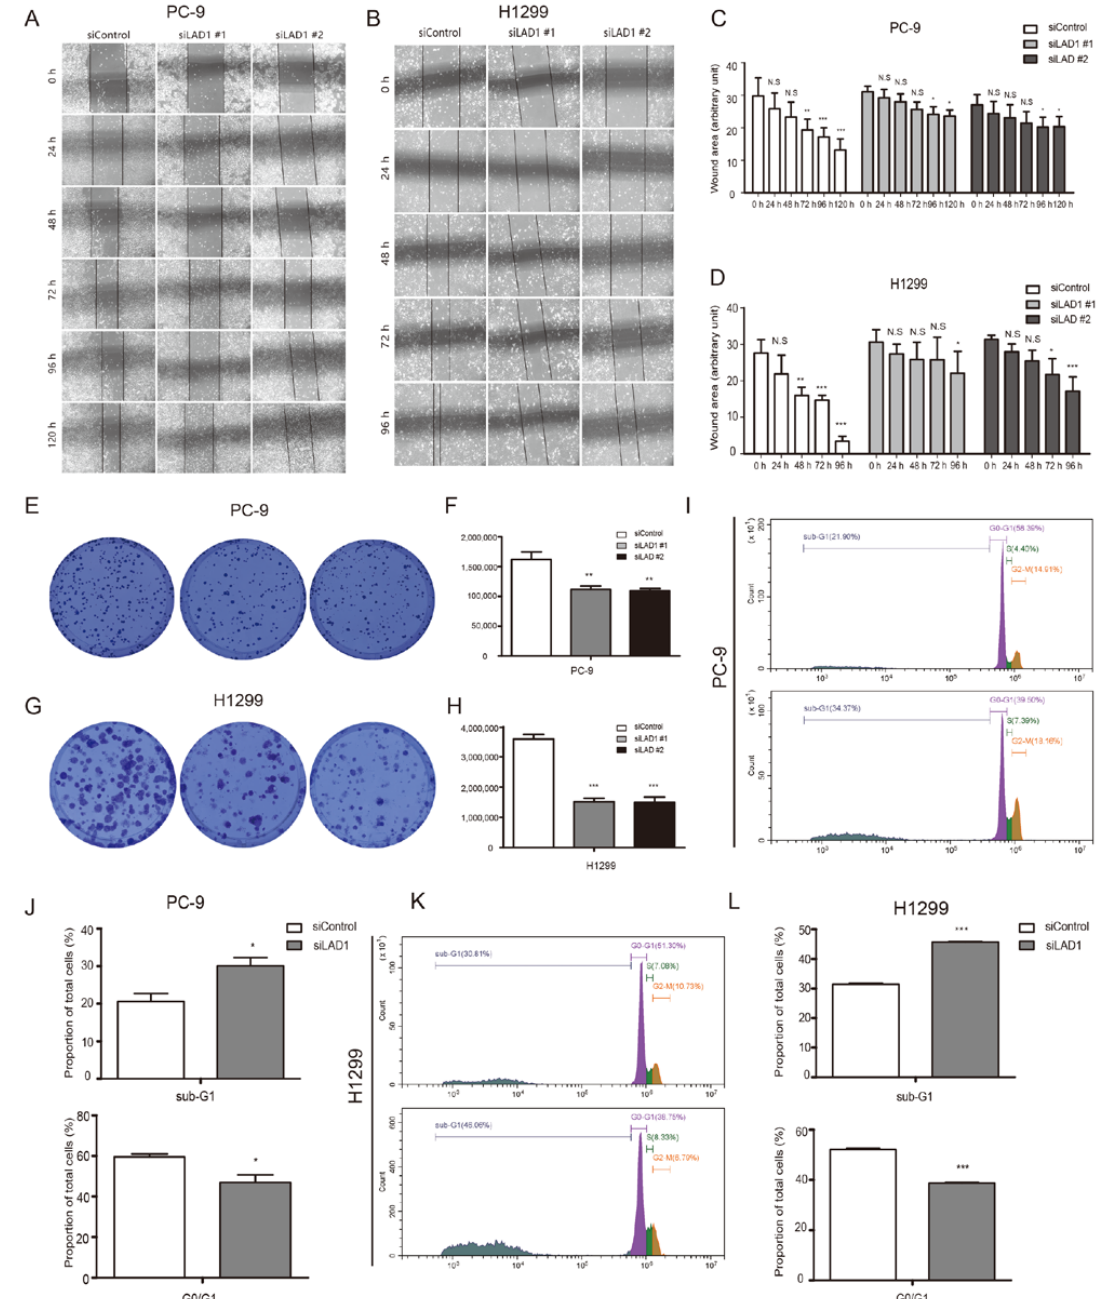
(Figure 6I–L), suggesting that LAD1 may be involved in the regulation of apoptosis. In summary, LAD1 might be critical for the migration, proliferation, cell cycle, and apoptosis of LUAD cells.